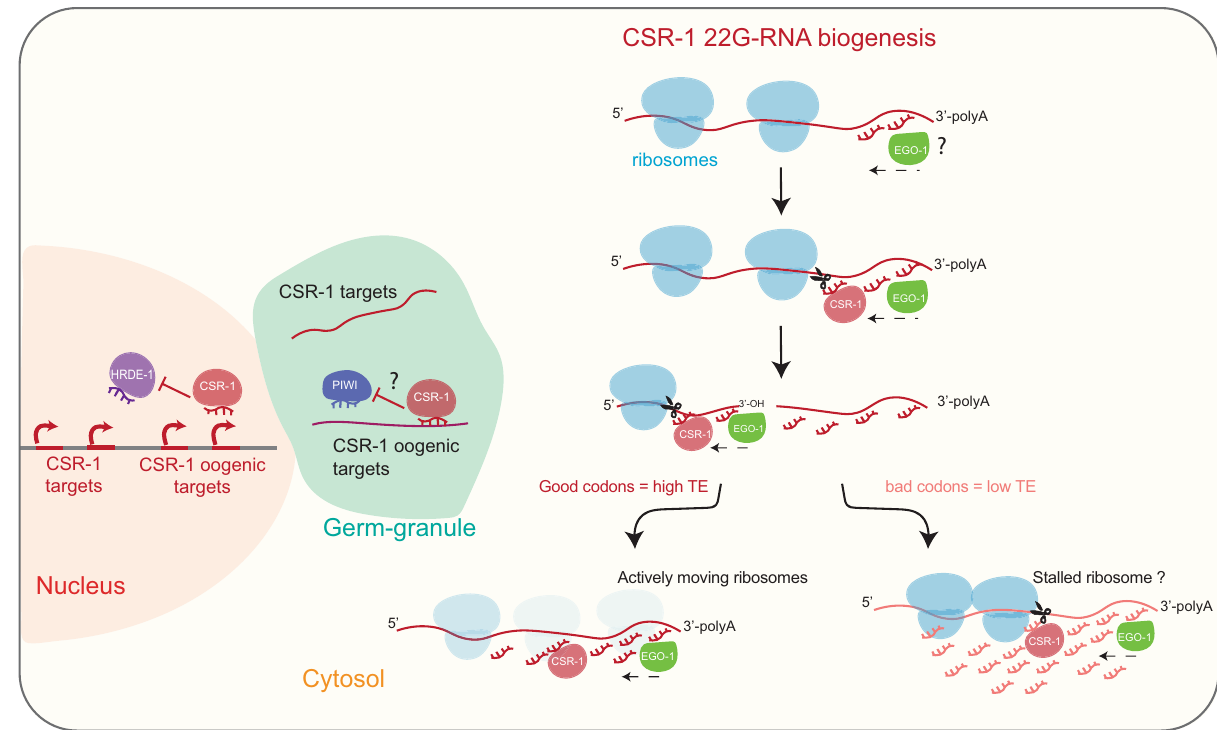
Fig. 7 Model illustrating biogenesis of CSR-1-22G-RNA in the cytosol. CSR-1 targets most of the germline-expressed genes. CSR-1 22G-RNAs are produced from mRNAs engaged in translation in the cytosol. We propose EGO-1 initiate 22G-RNA biogenesis at the 3 ʹ UTR on every actively translating mRNAs or by being recruited on speci fi c 3 ʹ UTR sequences by yet unknown mechanism. However, to produce 22G-RNAs on coding sequence, CSR-1 slicing activity is required on the mRNA template. Codon usage and translation ef fi ciency antagonistically regulate levels of 22G-RNAs production on different CSR-1 targets. We propose that CSR-1 can interact with ribosomes and the slicing event is more biased downstream of a possible stalled ribosome occupying a non-optimal codon site. CSR-1 slicer activity can regulate gene expression of few top targets, which further depends on the 22G-RNA levels. Additionally, CSR-1 can protect a set of mainly oogenic genes from piRNA-mediated HRDE-1 transcriptional silencing in a catalytic-independent